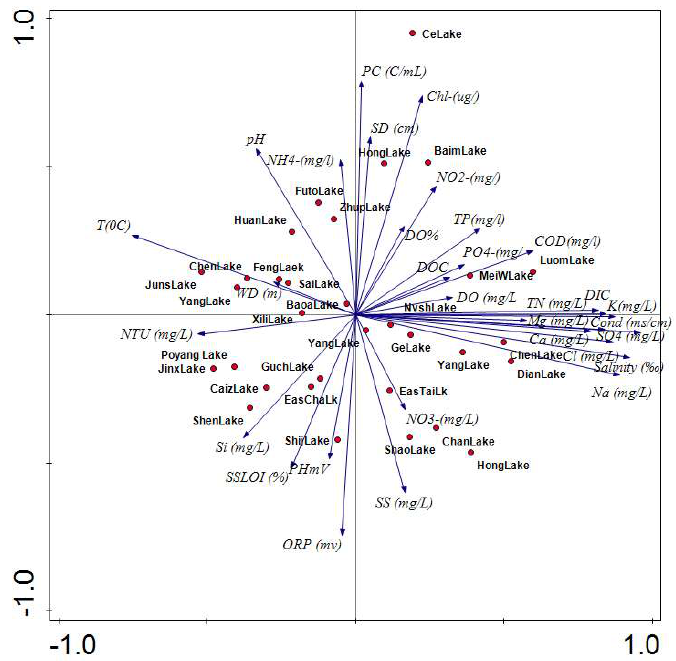
Figure 3. Principal components analysis of 31 physical and chemical variables from 32 lakes. SD = Secchi depth; DO (dissolve oxygen); SS = suspended solid; LOI = loss on ignition; WD = water depth; DOC = dissolve organic carbon; DIC = dissolved inorganic carbon; ORP = organic reactive phosphate; COD = chemical oxygen demand.